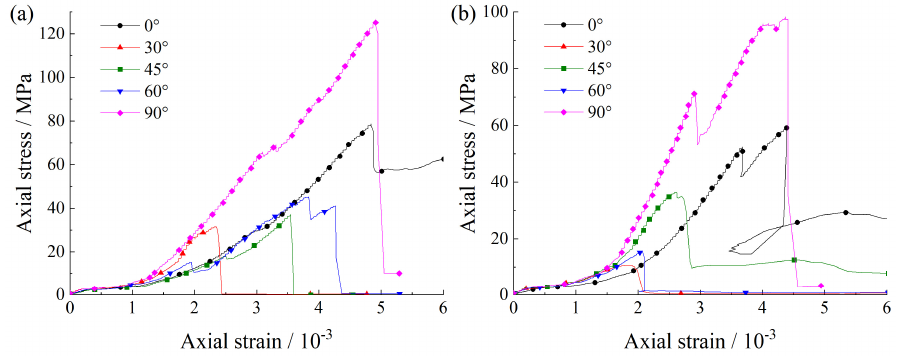
Figure 3. Axial stress-strain curves of layered phyllite with different bedding angles α . ( a ) Dry groups; ( b ) Water-saturated groups.